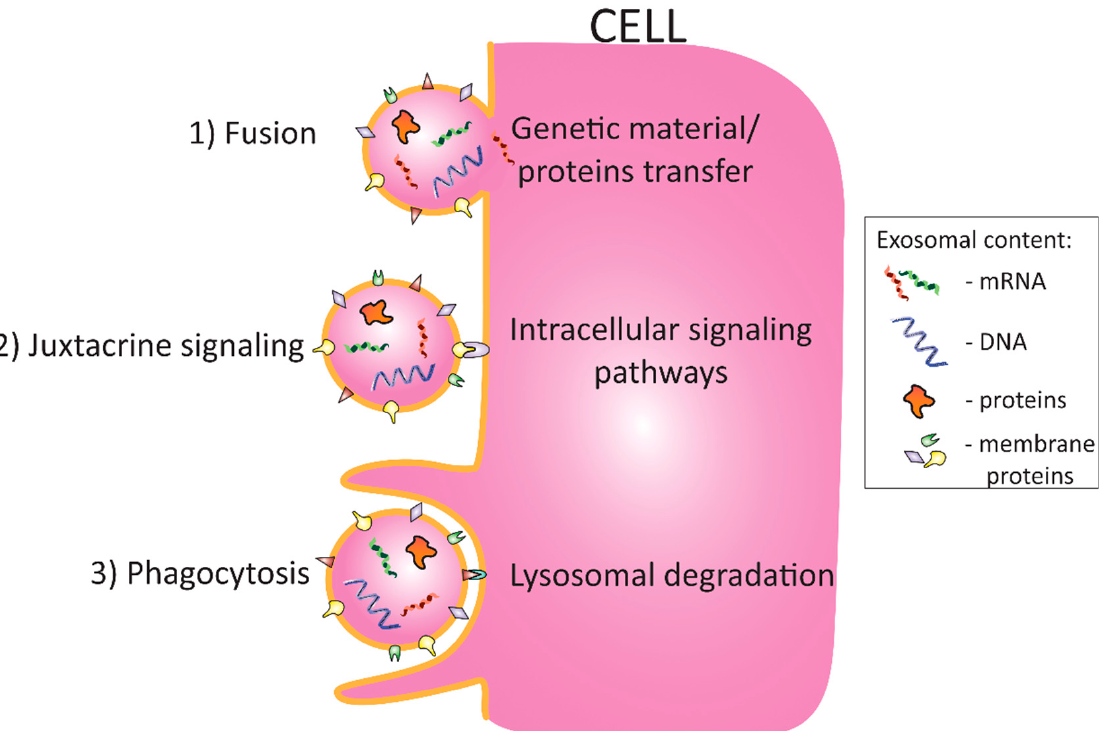
Figure 1. Exosome-target cell interaction: (1) membrane fusion allows for the transfer of both the internal cargo molecules and membrane proteins by merging with the plasma membrane of a target cell; (2) junxtacrine signaling activates intracellular signaling pathways through ligation of target cell membrane receptors with exosome membrane ligands; (3) phagocytosis allows for the internalization of the whole exosome by target cell. It allows for the lysosomal degradation of exosomes. The biological effects of exosomes’ action depend on a type of interaction with the target cell [7].